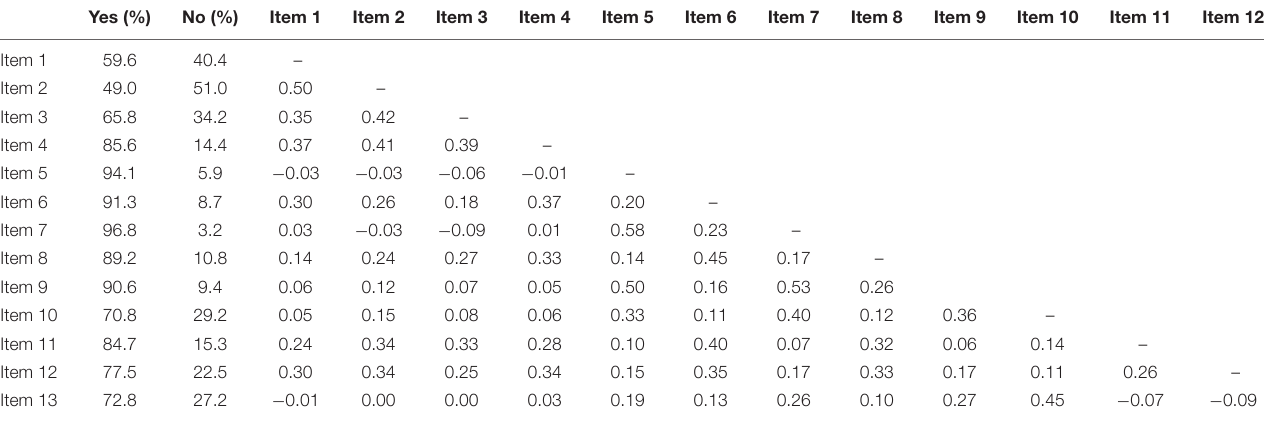
TABLE 2 | Pattern of responses across items and matric of tetrachoric correlation ( n = 2,407).